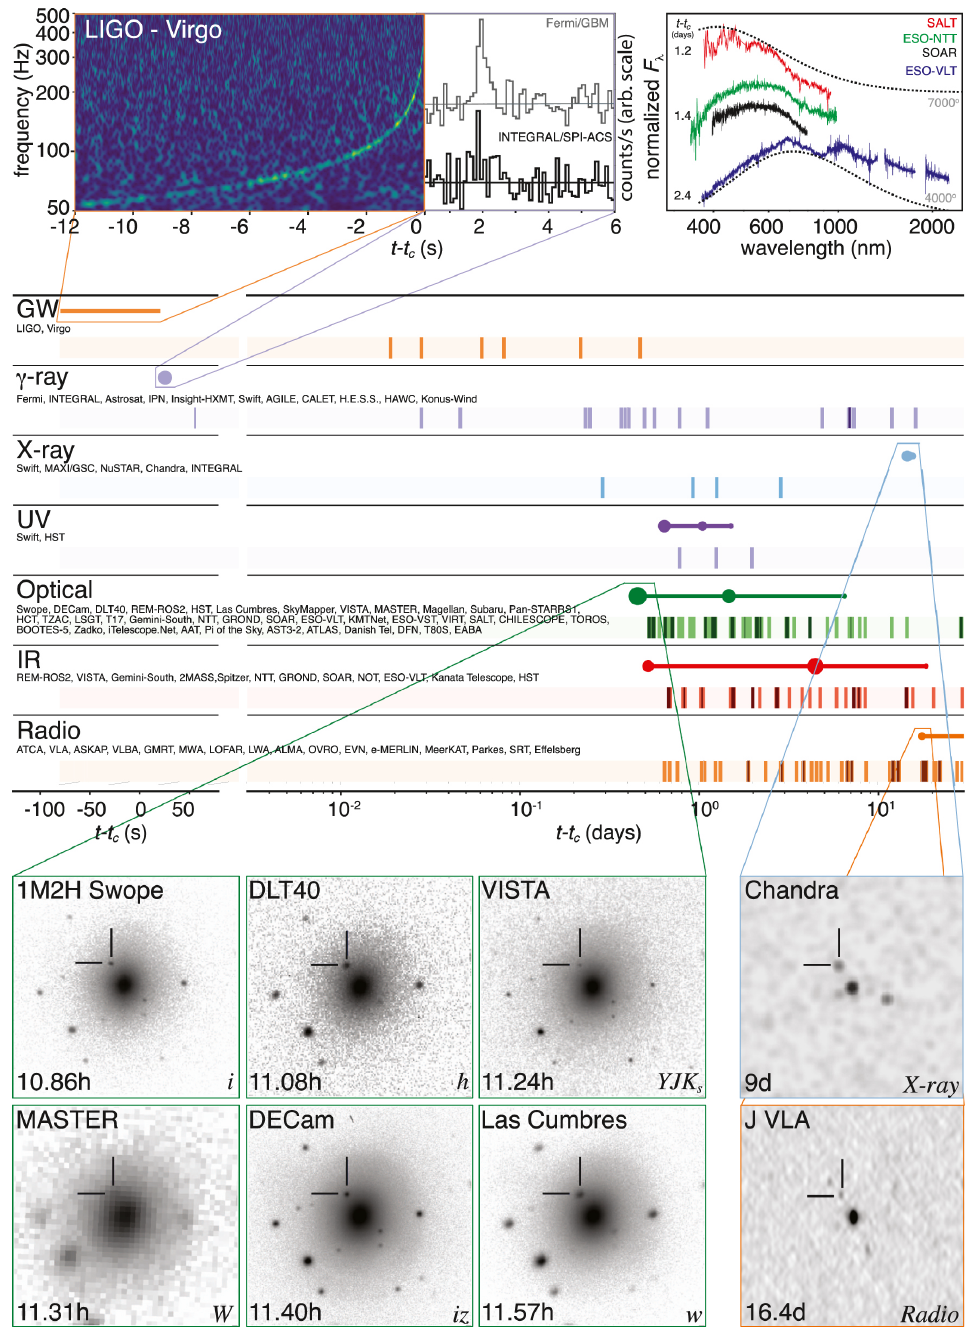
Figure 1. Top left panel: Gravitational wave signal of GW170817 represented in the time-frequency domain, and the associated short GRB detected independently with Fermi and INTEGRAL. Temporal scale is centered on the coalescence epoch t − t c = 0 and clearly shows how the GRB trigger lagged 1.7 s the merger. Top right panel: Kilonova (AT2017gfo) nearly thermal optical spectrum taken at different epochs. Central panel: Timeline of the discovery of the electromagnetic counterparts (GRB 170817A and AT2017gfo) during the follow-up campaign. Bottom left panel: Images of AT2017gfo and the host galaxy NGC 4993. Bottom right panel: Images of the X-ray and radio afterglow of GRB 170817A. Figure taken from